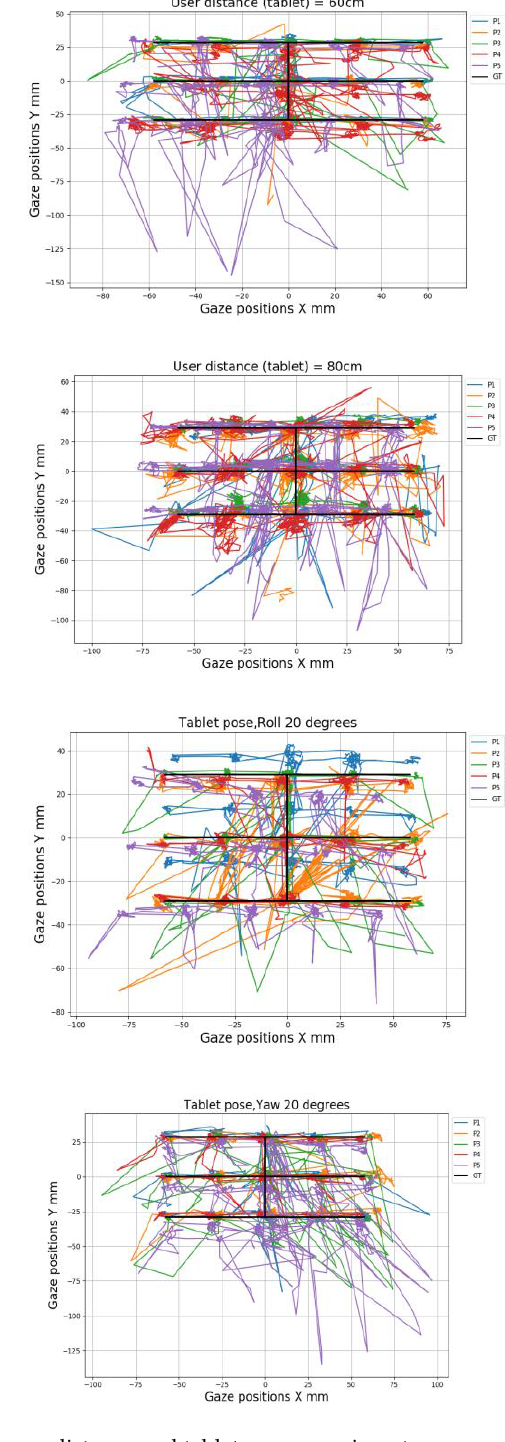
Figure A2. Gaze data from tablet-based user distance and tablet pose experiments.